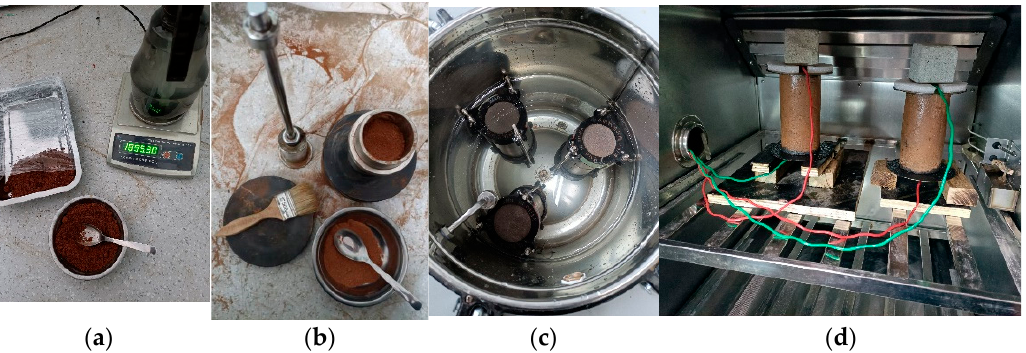
Figure 1. Indoor experiment: ( a ) soil sample preparation, ( b ) soil specimen production, ( c ) saturated specimen and ( d ) temperature and humidity control.